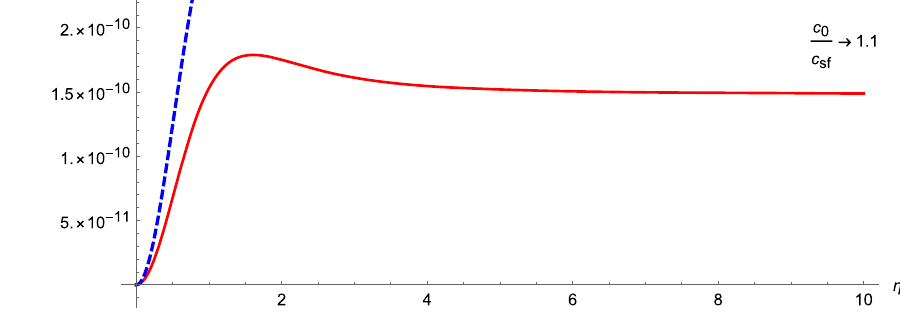
Fig. 2 Dispersion for free particles for different values for the sound speed and β = 3 . 6 × 10 − 8 . The dispersion increases when LIV is